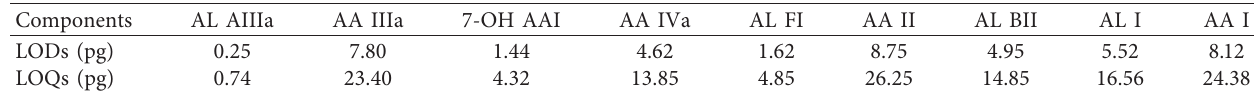
Table 3: LODs and LOQs for 9 aristolochic acid analogues.